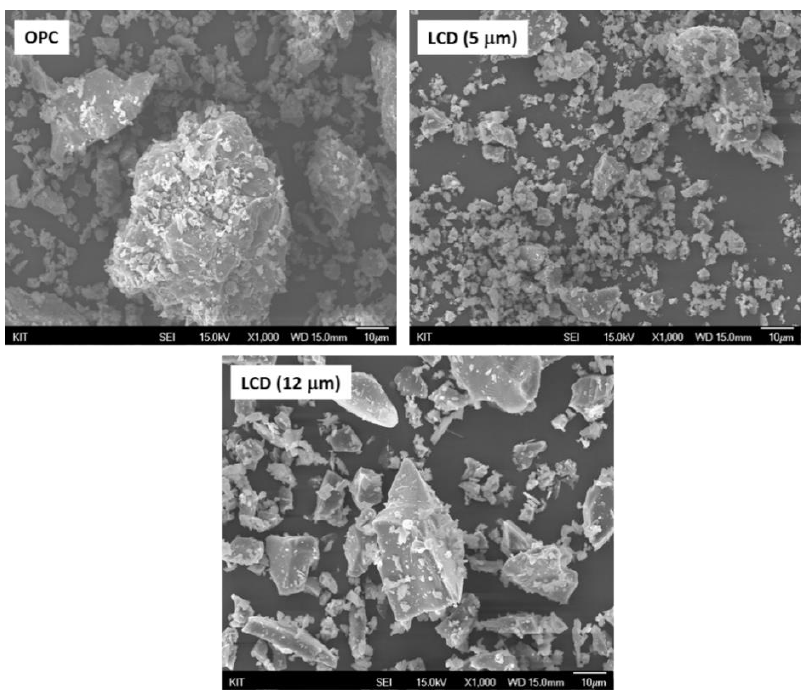
Figure 2. SEM images of raw material particles.